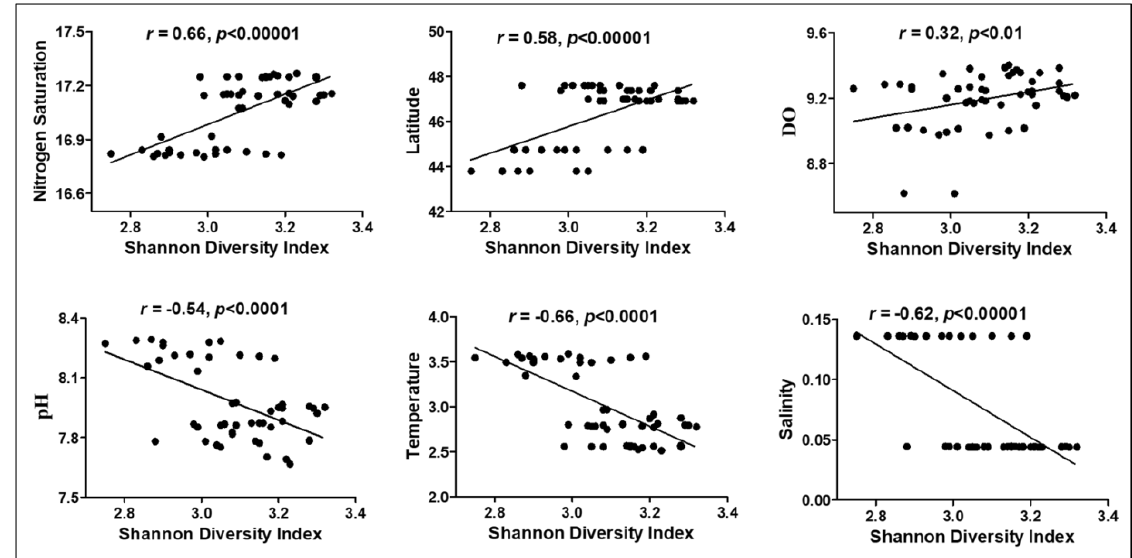
Figure 10. Linear regression analysis between Shannon diversity index and environmental variables. The Shannon diversity index and environmental variable values are given in the x and y axes, respectively. Correlation coefficient and p -values are provided in the figure description.